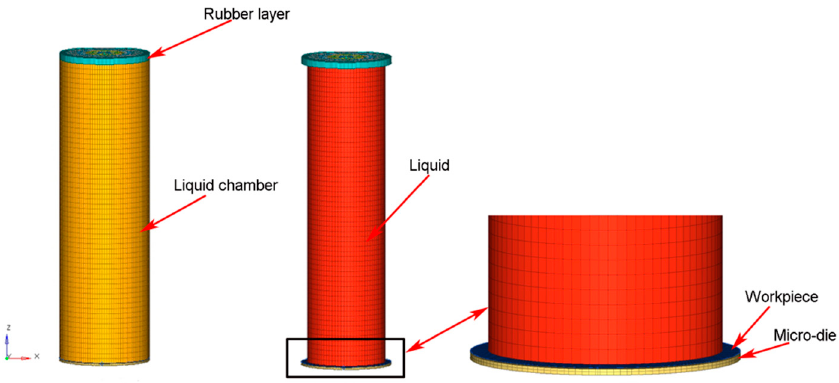
Figure 3. The numerical model of laser impact liquid flexible embossing process.